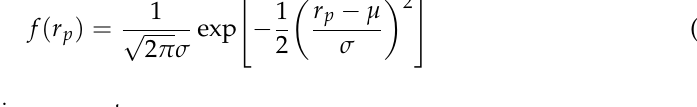
Table 3. Pore size distribution parameters.